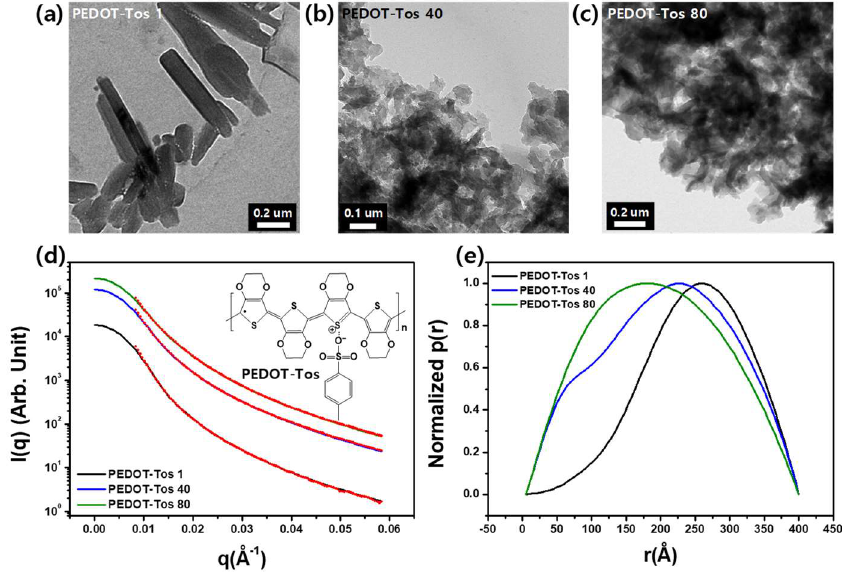
Figure 2. Transmission electron microscopy (TEM) images of the in situ polymerized and doped ( a ) PEDOT-Tos 1, ( b ) PEDOT-Tos 40, and ( c ) PEDOT-Tos 80 are presented. Additionally, ( d ) small-angle X-ray scattering (SAXS) analysis of PEDOT-Tos is also shown. The experimental intensities were plotted and fitted (red dotted curves) by the GNOM program. ( e ) Normalized p ( r ) was plotted by the GNOM program [33].